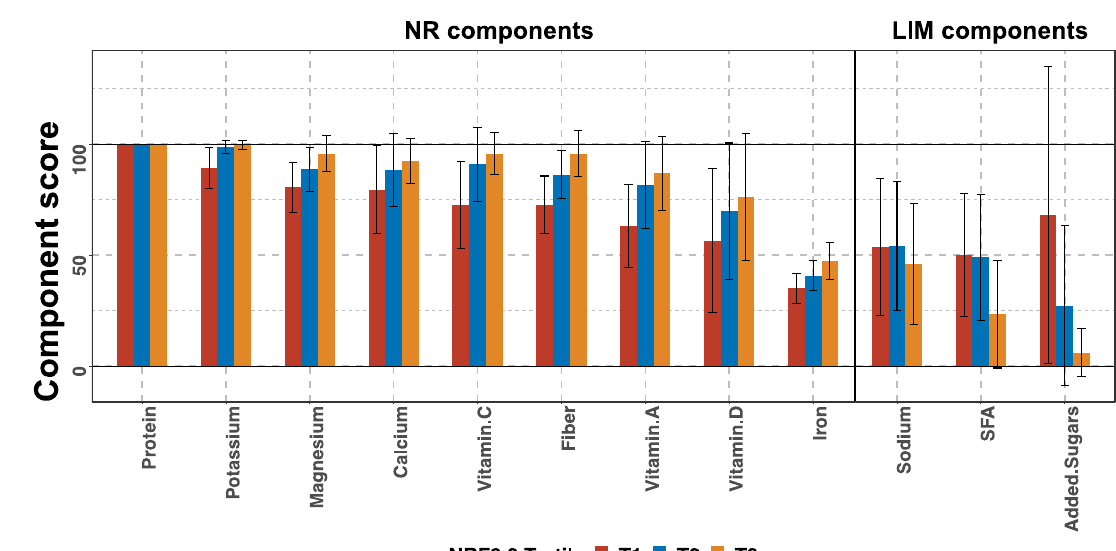
Figure 3. Component scores according to the tertiles (T) of total Nutrient-Rich Food Index 9.3 (NRF9.3) score in pregnant women of a birth cohort, BC-GENIST, in Japan. Bars show the mean and error bars represent standard deviation (SD). The nutrients constituting the nutrient-rich (NR) and limiting nutrient (LIM) sub-scores are shown from left to right, from the highest to lowest mean score of the entire cohort. For the NR sub-scores, a higher score indicates a higher dietary quality, while for the LIM sub-scores, a higher score indicates a lower dietary quality. SFA, saturated fatty acids. n = 36 (T1), 36 (T2), and 36 (T3).